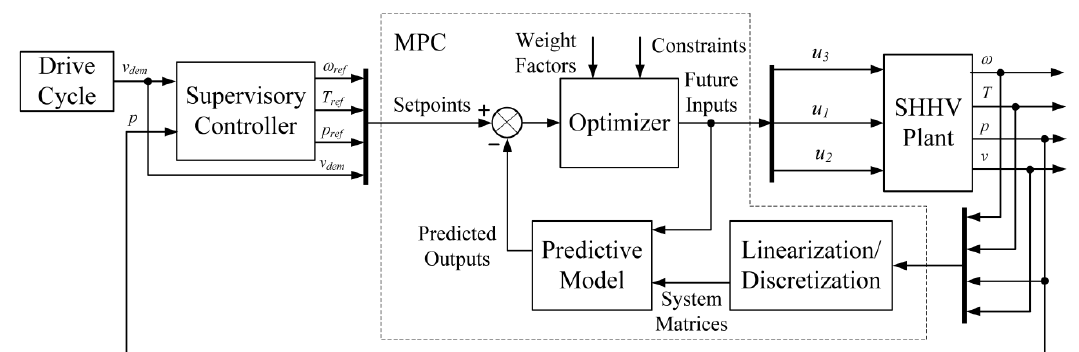
Figure 7. Schematic of the MPC-based control system.